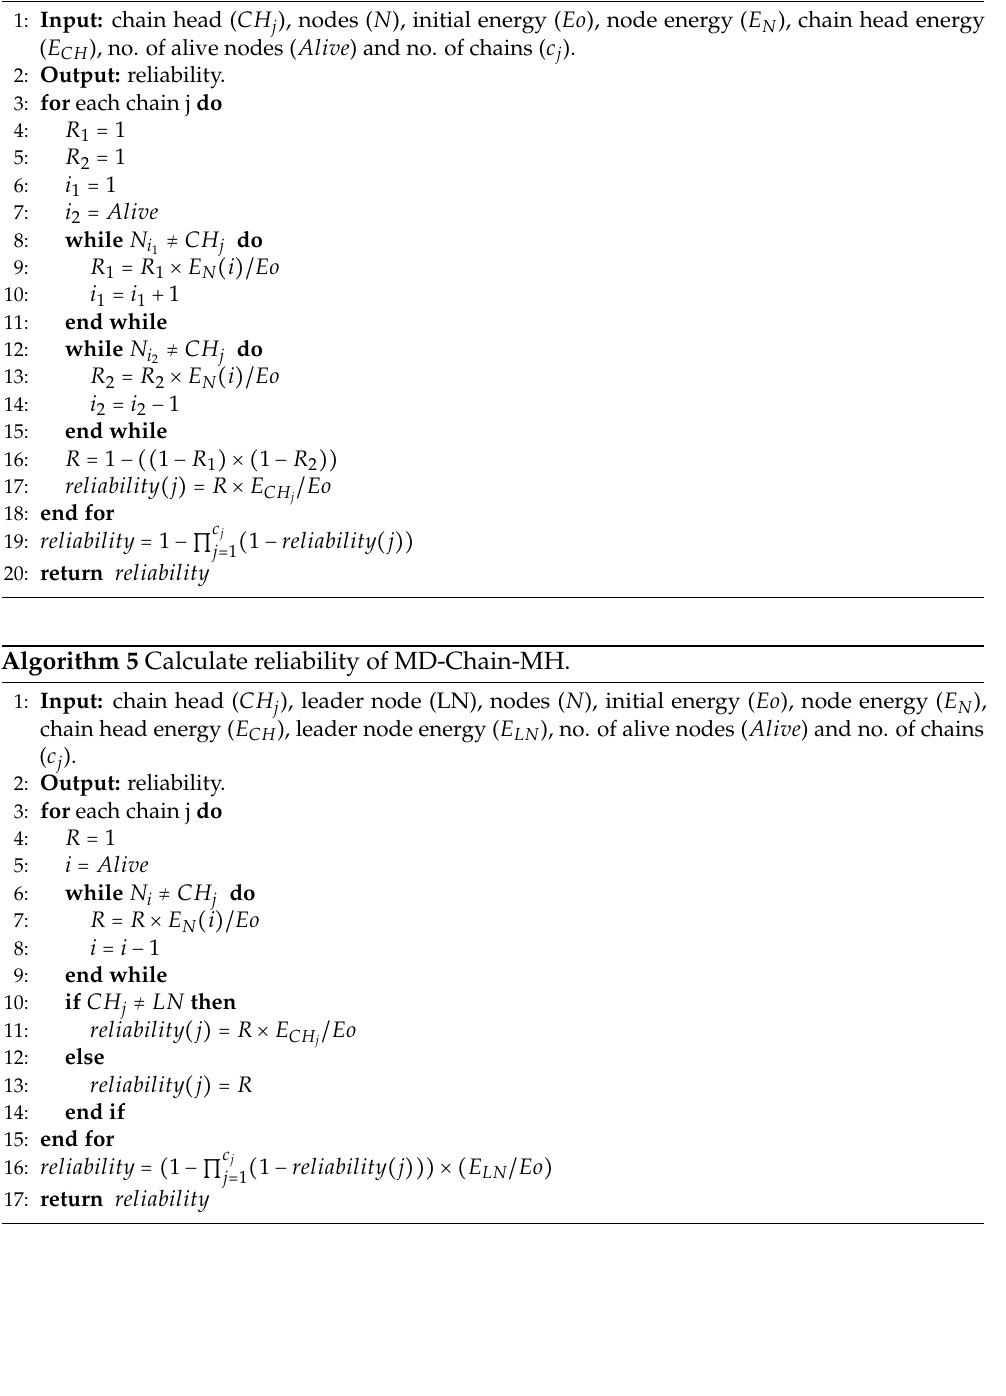
Algorithm 4 Calculate reliability of MQ-Chain-SH.